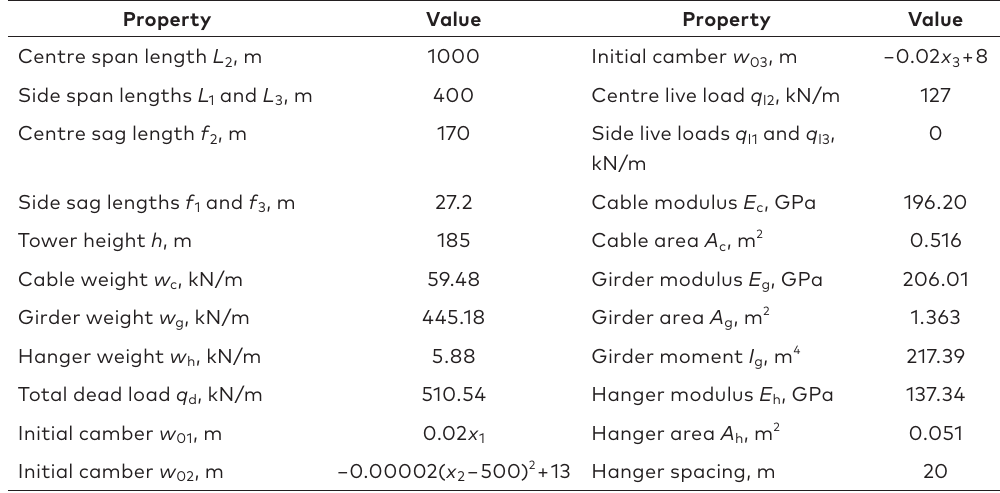
Figure 3. Deflections of the main cable and girder Table 1. Geometric, loading and material properties of a bridge example